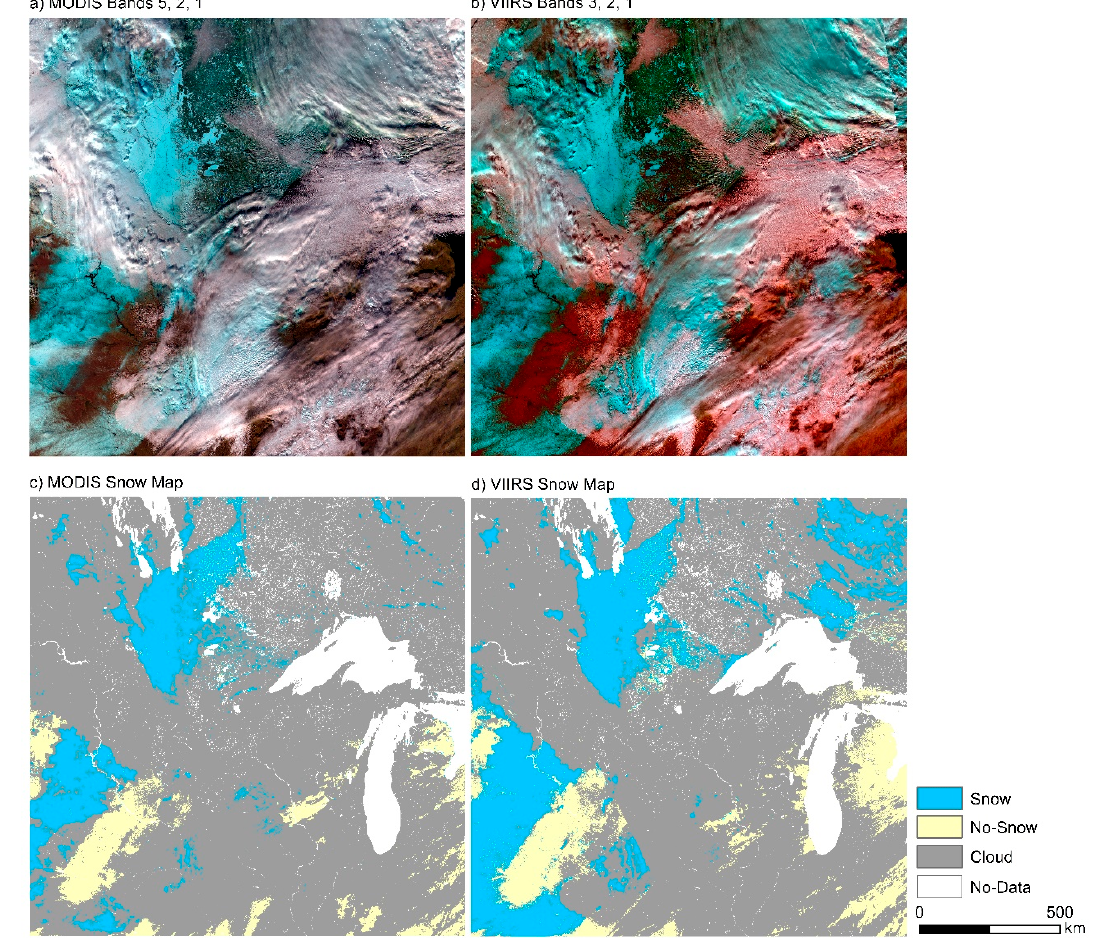
Figure 9. Qualitative comparison during Dec 24, 2015. ( a ) A false-color composite image of MODIS bands 5 (1230–1250 nm), 2 (841–876 nm), 1 (620–670 nm) as R, G and B that shows snow as cyan colors; ( b ) a false-color composite image of VIIRS bands I3 (1580–1640 nm), I2 (846–885 nm), I1 (600–680 nm) as R, G and B that shows snow as cyan colors; ( c ) MODIS binary snow map and ( d ) VIIRS binary snow map.